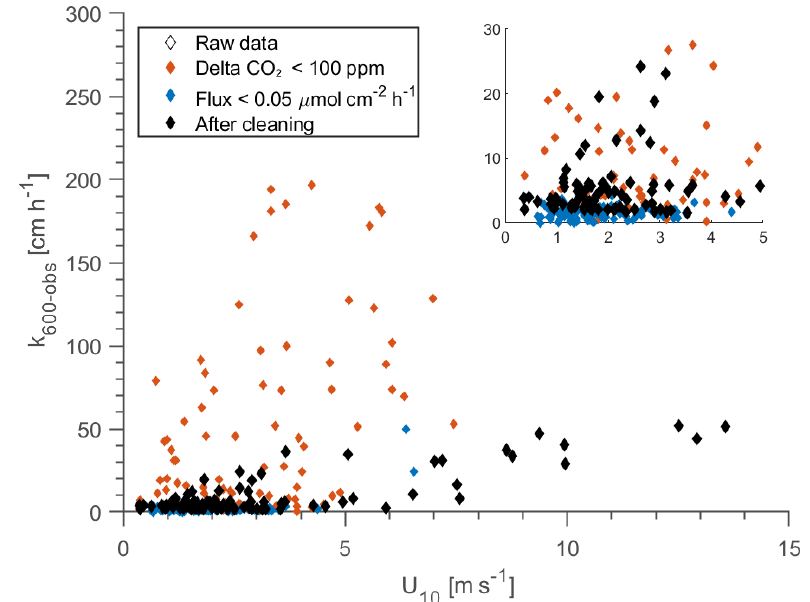
Figure A3. Visualisation of 304 observed k 600 values during the five periods of flux measurements: 13–14 June 2019, 27–28 August 2019,